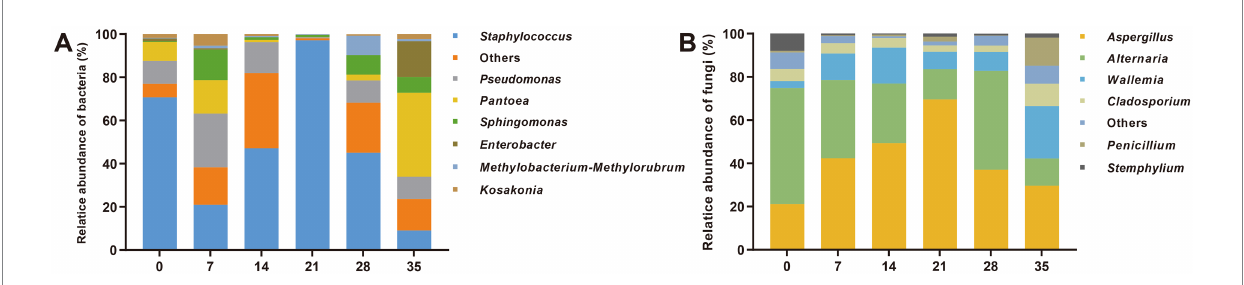
FIGURE 2 Changes in microbial community structure during fermentation of cigar tobacco leaves. (A) Bacteria; (B) fungi. The numbers 0, 7, 14, 21, 28, 35 indicated the fermentation